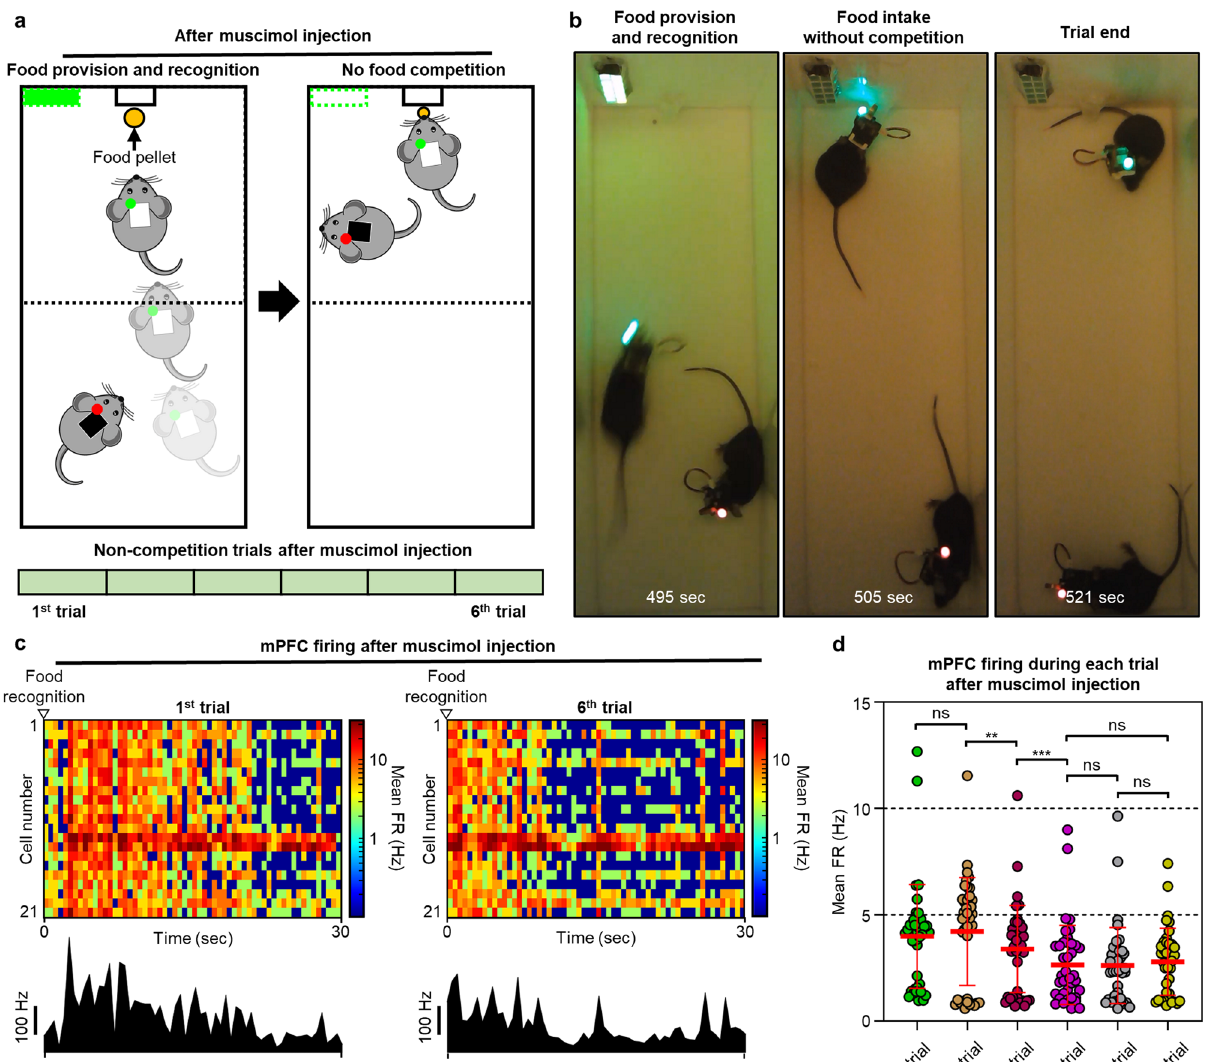
Fig. 7 | Drug-induced modulation of the food competition and simultaneous monitoring ofthe neural and social interaction changes. a Neural activities of a green mouse (mPFC neurons) and a red mouse (LH neurons) in accordance with competitionpatternsduringarepresentativefoodcompetitiontestwithmuscimol injection into the LH of the red mouse. The blue line above the heatmap indicates the time at the pump on (3 cycles; 5s on and 55s off over a 60s period). b , c Real- time fi ring rate of mPFC neurons and LH neurons in accordance with behavioral events during a representative food competition trial b before and c after the muscimol injection. d Representative photographs taken before and after the muscimol injection, showing the absence of competition after the muscimol injection. e Overall winning history and competition occurrence before, during, and after the muscimol injection during four food competition tests conducted